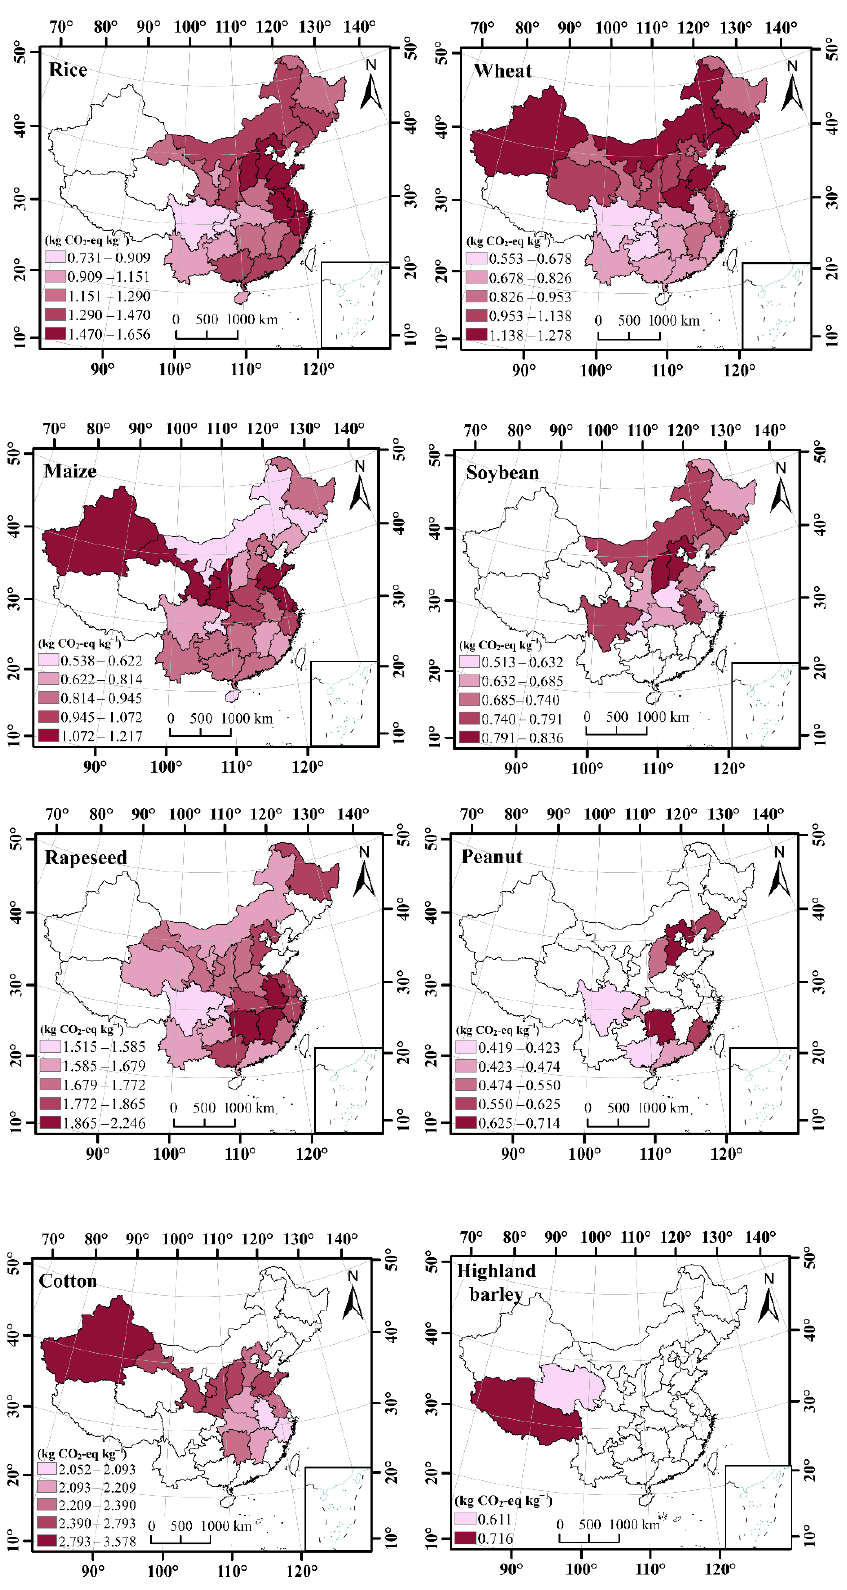
Figure 4. Spatial distributions of the carbon footprint per unit yield ( CF Y ) for different crops in China from 1990 to 2019.